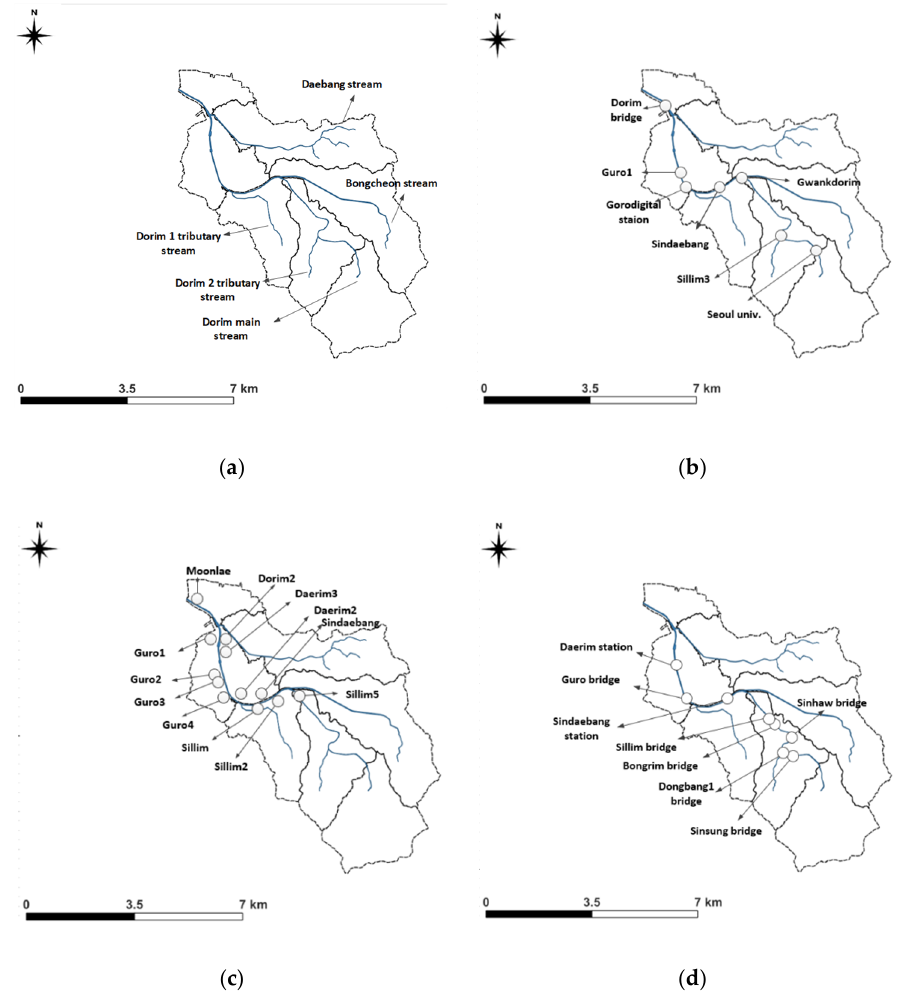
Figure 3. Map of the study area in Dorim basin. ( a ) River. ( b ) Waterlevel station. ( c ) Pump station. ( d ) Flood-stricken areas.